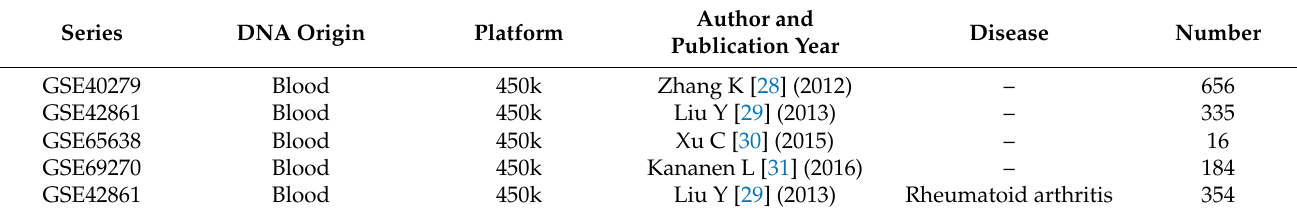
Table 1. Four healthy and one disease DNA methylation